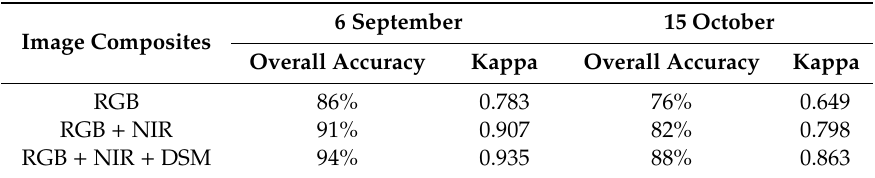
Table 5. Accuracy assessment results for three image composites at the Budai sampling site. Image Composites